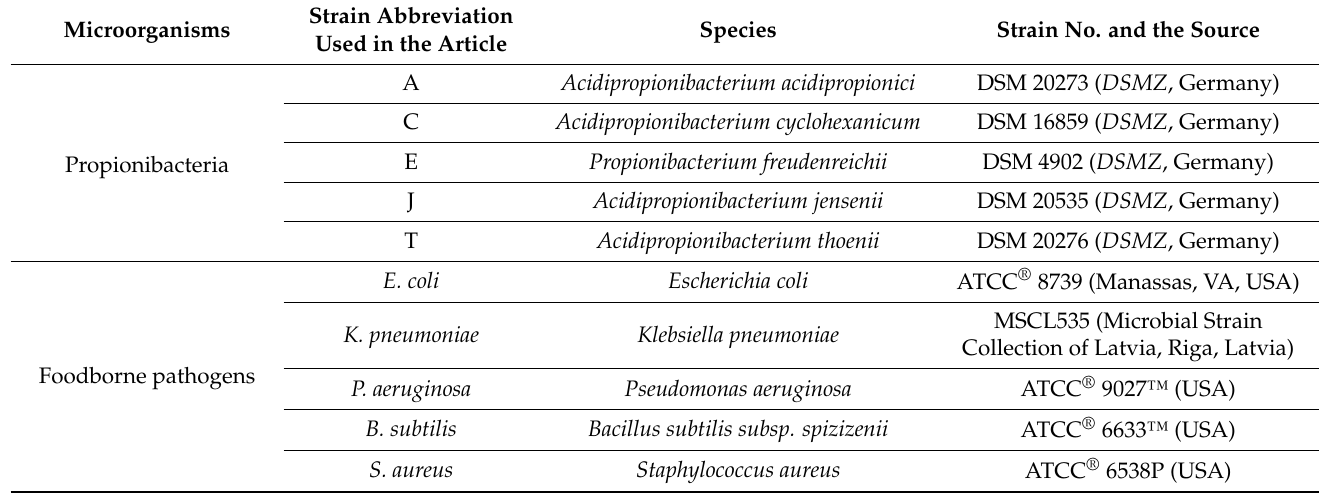
Table 1. Microorganisms used in the